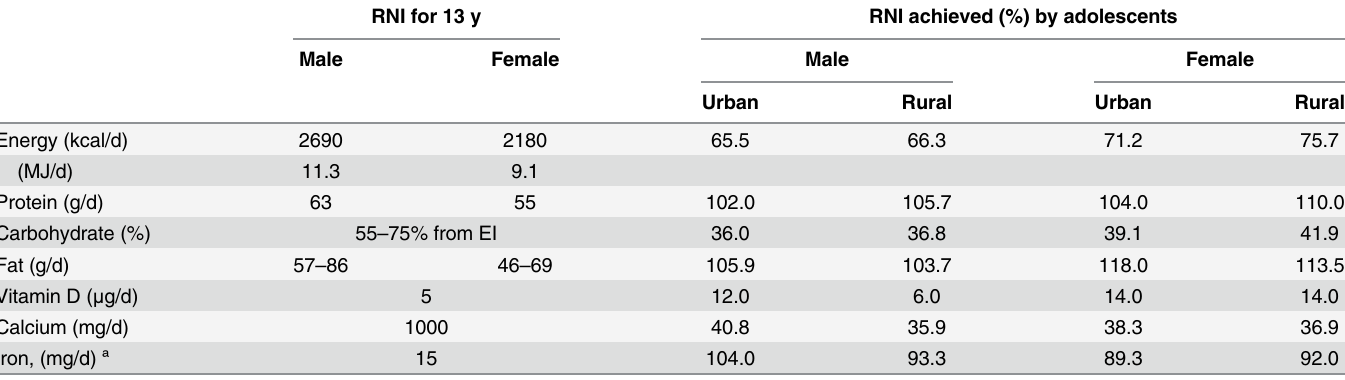
Table 3. Energy, macronutrient and micronutrient intakes and percentages, of recommended nutrient intake (RNI, 2005) achievements, of the ado- lescents by gender and places of residence.